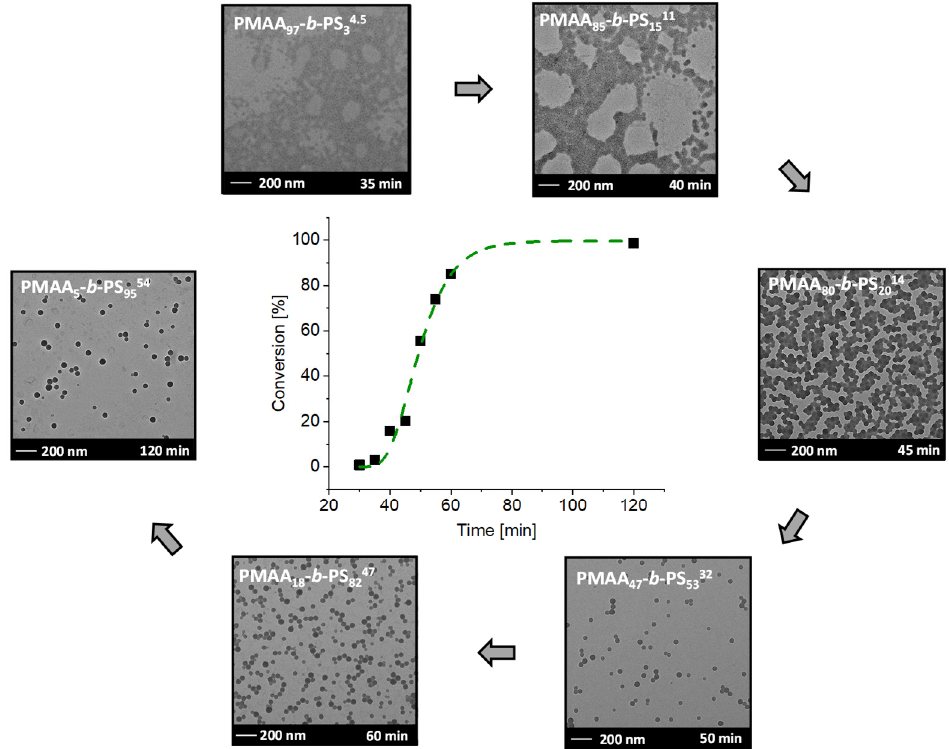
Figure 6. Conversion versus reaction time of the RAFT emulsion polymerization of PMAA 5 - b -PS 9554 with CTA1 and a targeted DP of [MAA]/[CTA] = 30 and [Sty]/[CTA] = 502 and a molar ratio of [CTA]/[ACVA] = 5 at 80 °C and the corresponding TEM images after a specific time. The subscripts in the designation of the polymers represent the molar fraction of the respective block in wt% and the superscript represents the overall molecular weight in kDa.